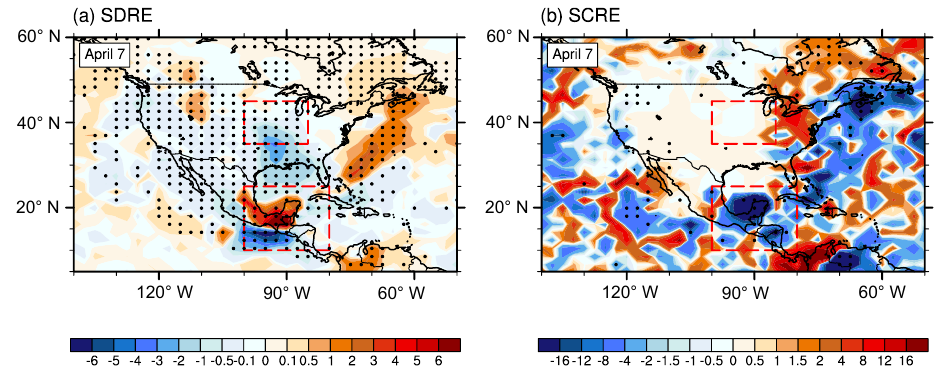
Figure 11. Spatial distributions of ensemble mean fire aerosol (a) SDRE and (b) SCRE (Wm − 2 ) on 7 April in the E_QF simulation. Dots denote grids where the fire aerosol effect is statistically significant at the 95% confidence level based on the KS test.